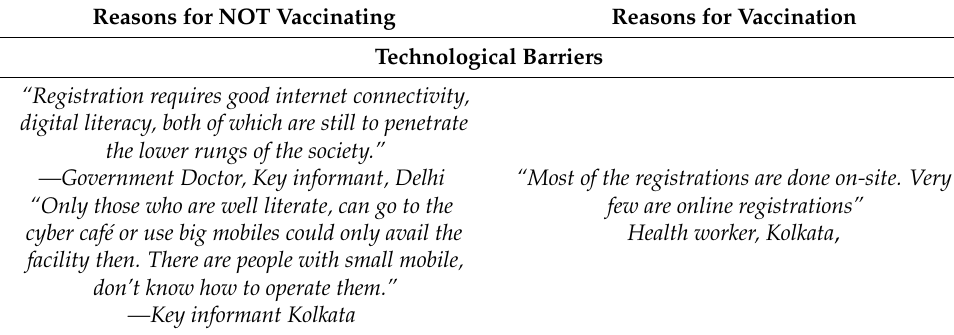
Table 10. Description of theme technological barriers with verbatim.